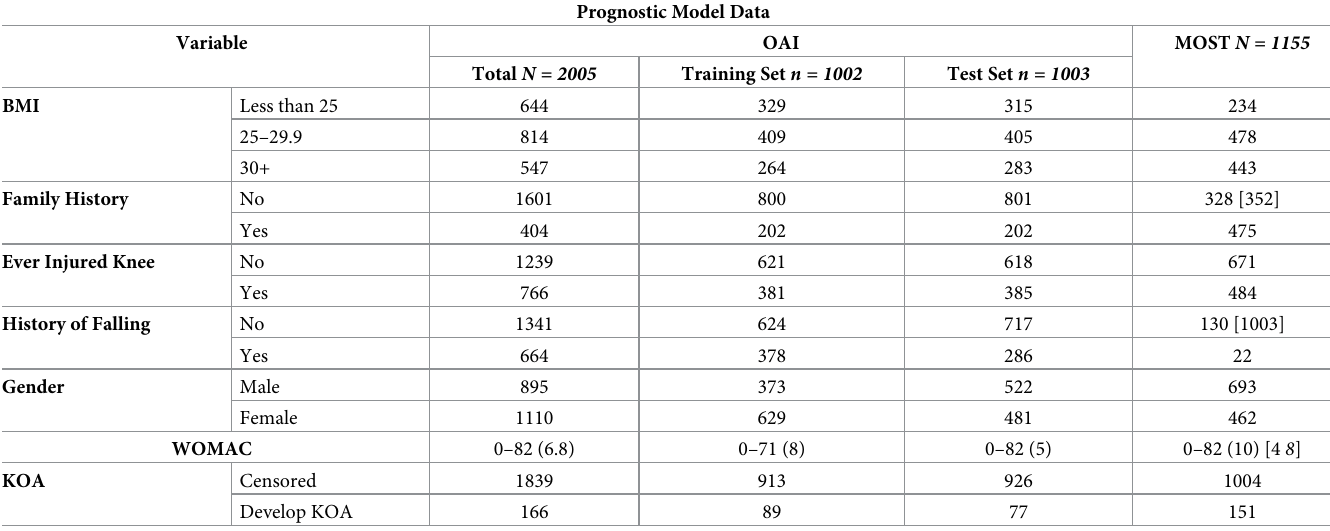
Table 2. Prognostic model summary information of the Osteoarthritis Initiative (OAI) and Multicentre Osteoarthritis Study (MOST) datasets.